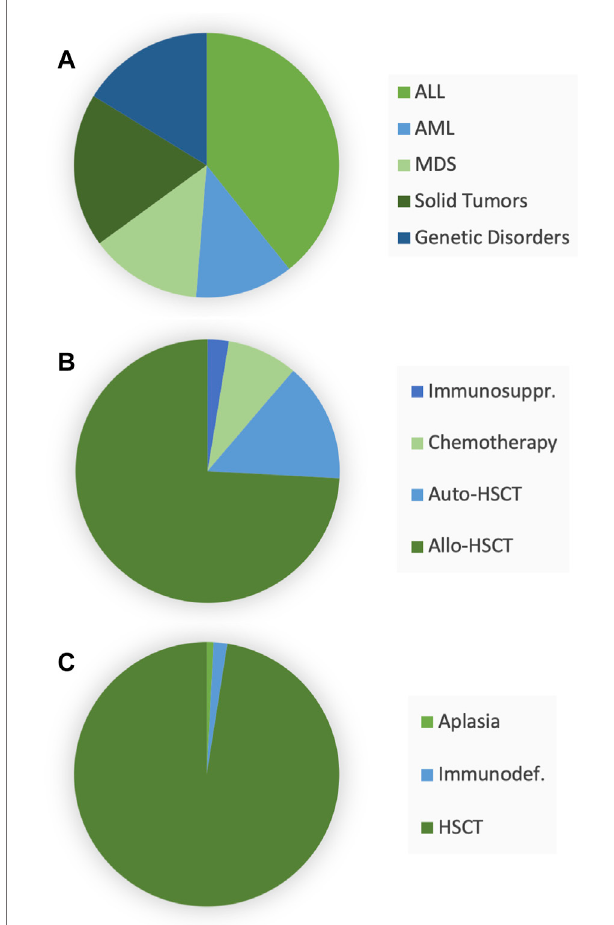
FIGURE 1 | Characteristics of the 120 enrolled patients: initial diagnosis (A) , fi rst-line therapy (B) , and reasons for acyclovir administration (C) . Abbreviations: ALL, acute lymphoblastic leukemia; AML, acute myeloblastic leukemia; MDS, myelodysplastic syndrome; HSCT, hematopoietic stem cell